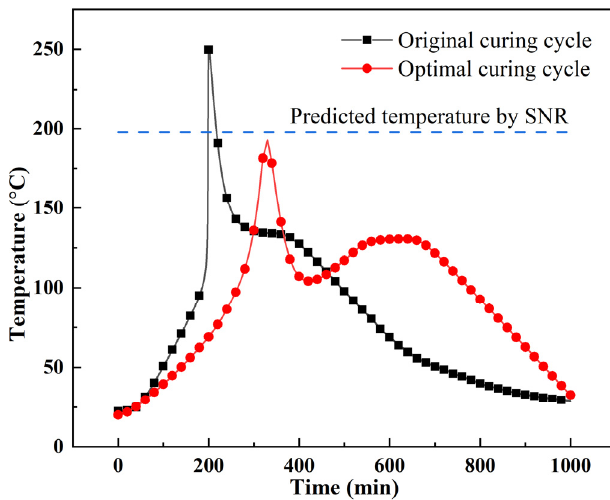
Figure 14. Comparison of experimental and prediction results.